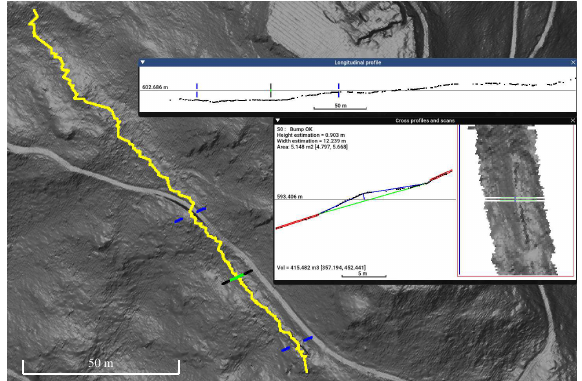
Figure 7. Detection and analysis of Wall 1 structure; local trends in red, detected bump in blue, baseline in green; blue strokes: measure bounds, green stroke: input trend.